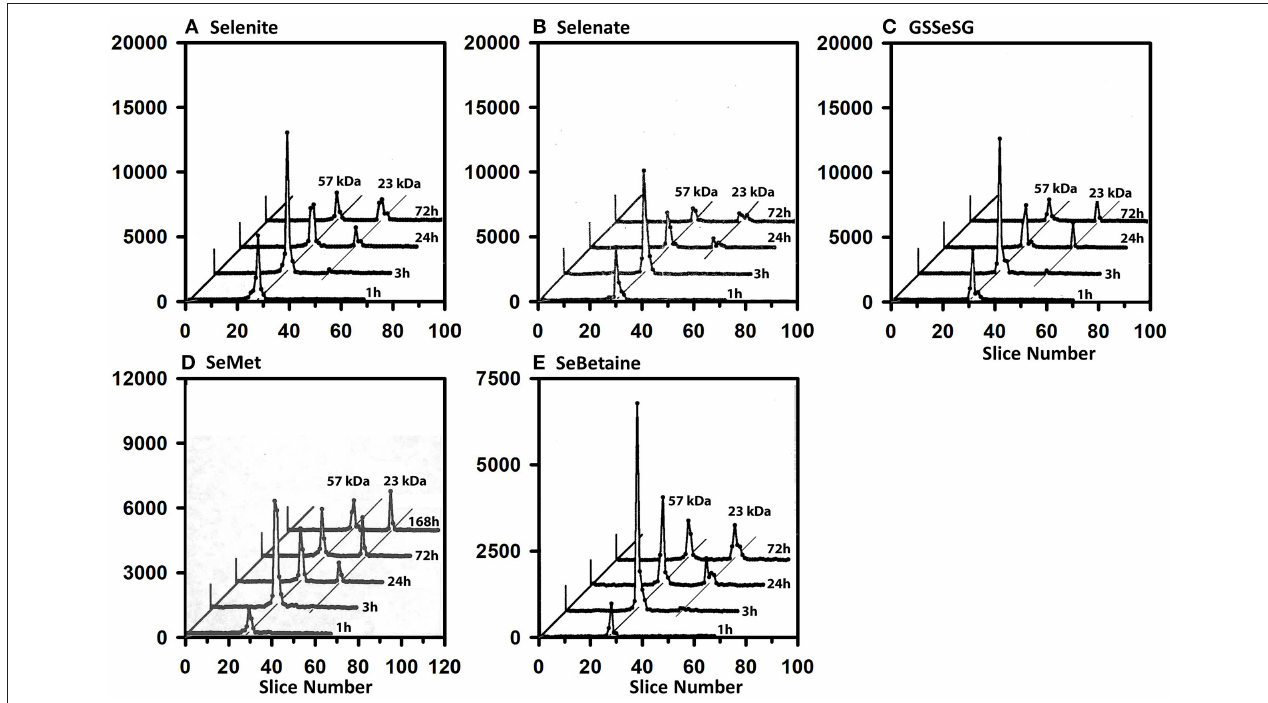
FIGURE 3 | Incorporation of 75 Se into plasma proteins. Rats were fed 0.2 µ g Se/g diet as selenite for 50–80 d, injected iv with 50 µ Ci of tracer 75 Se-labeled Selenite (A) , Selenate (B) , GSSeSG (C) , SeMet (D) , and SeBetaine (E) , and killed at 1, 3, 24, or 72h (or 168h for SeMet) afer dosing. Plasma samples (1,500 µ g protein) were separated using gradient SDS/PAGE. Sample lanes in each gel were cut into 2-mm slices and counted. The cpm for each slice are plotted to show 75 Se incorporation into selenoproteins of different subunit molecular weights. Slice 1 contains polypeptides of the highest molecular weight. Plots for 3, 24, and 72h were staggered, and diagonal lines are drawn through the major 75 Se proteins to show the change in 75 Se incorporation in these species with time. Each time profile in each selenocompound panel is from one rat ( n = 21 total rats). Plasma SELENOP is 57 kDa and GPX3 is 23